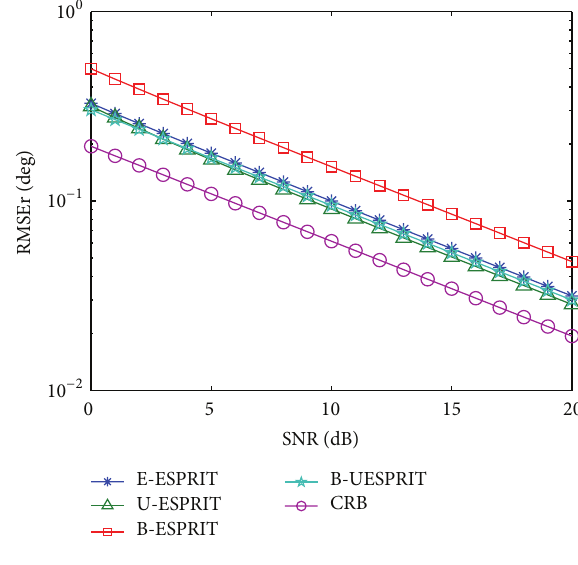
Figure 5: DOA estimation performance comparison.